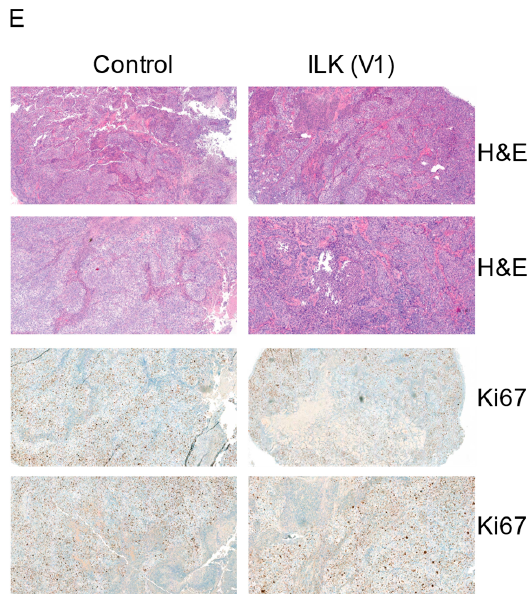
Figure 6. ILK-1 is important for SKOV3 tumor growth. ( A ) ILK-1 was knocked out using three CRISPR/Cas9 sgRNA. Western blot shows the knockout in SKOV3 cells. Control sgRNA was used in the vector-infected group. ( B ) Control and ILK-1 sgRNA knockdown cells (virus 1) were implanted in NSG mice ( n = 15/group). Tumor uptake and growth were measured over the course of this study. Animals were sacrificed at the end of this study, tumors were isolated, and stored for further analysis. ( C ) Western blot in the tumors from animals described in panel B is provided. V1 corresponds to virus 1 (clone 1) of the three clones that were screened. ( D ) RNA was isolated from the tumors and the expression of genes in the vector or ILK-1 knockdown tumors ( n = 3/group) was measured by microarray. ( E ) Representative H&E and ki67 staining of tumor sections. Statistically different genes between the two groups are represented as heatmap. ** p < 0.01.